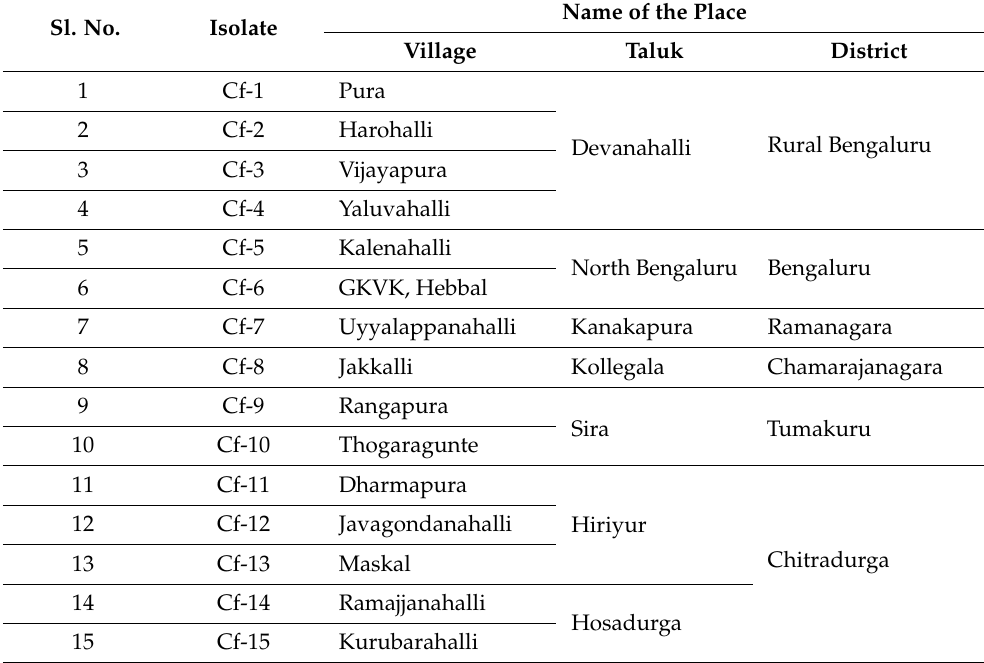
Table 1. Isolates of Ceratocystis fimbriata collected from different southern districts of Karnataka used in this study. Name of the Place Sl. No. Isolate Village Taluk District 1 Cf-1 Pura 3 Cf-3 Cf-4